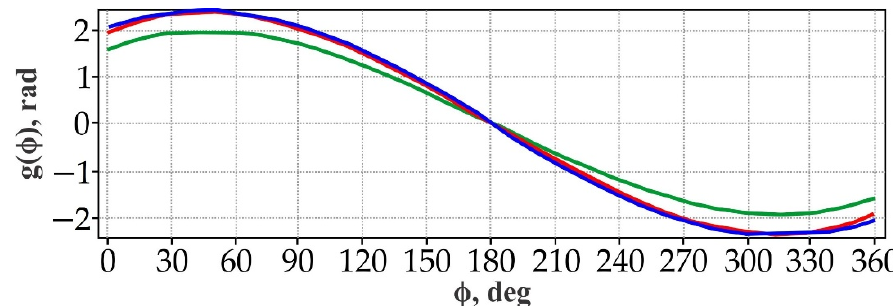
Figure 6. Phase functions: g 1 ( φ ) defined by Equation (37) (blue line), g 2 ( φ ) defined by Equation (38) (green line), and g 3 ( φ ) defined by Equation (39) (red line).